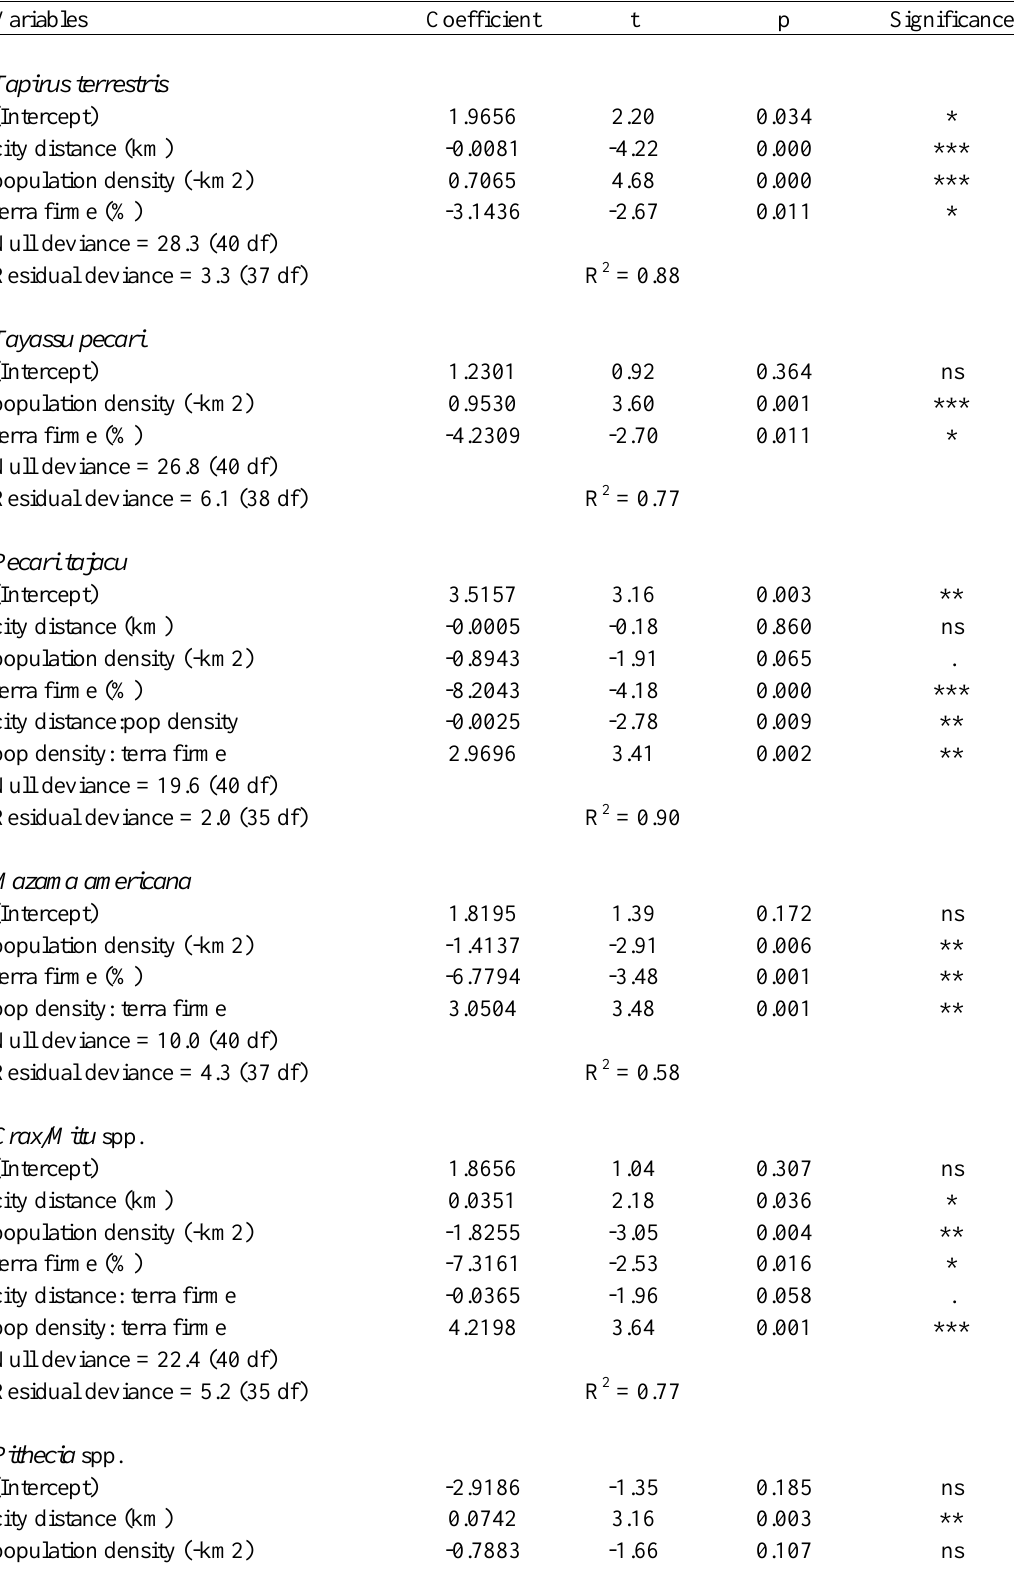
Table A4. Results of minimal Generalized Linear Models of proportional faunal depletion of census sectors, for those sectors for which field surveys allowed a full census of the human population (n=41). A quasi-binomial error structure was specified. Significance levels refer to: p < 0.1 (.); p < 0.05 (*); p < 0.01 (**); p < 0.001